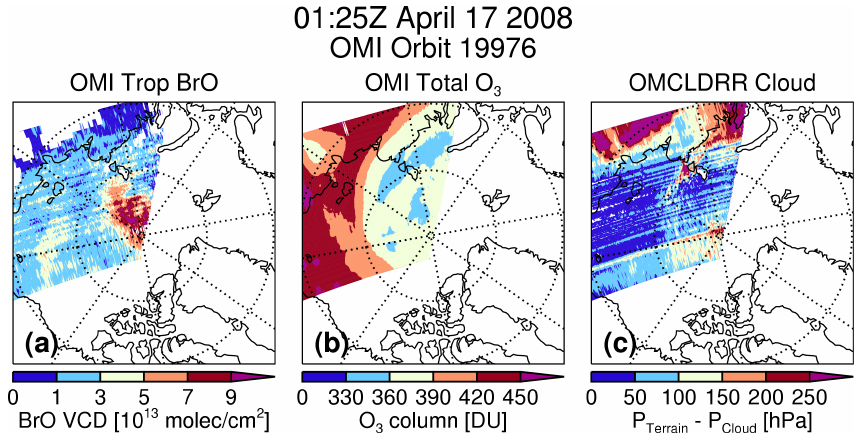
Fig. 12. (a) OMI tropospheric BrO VCD; (b) OMI total ozone column; (c) terrain minus cloud pressure for OMI orbit 19976 on 17 April 2008.